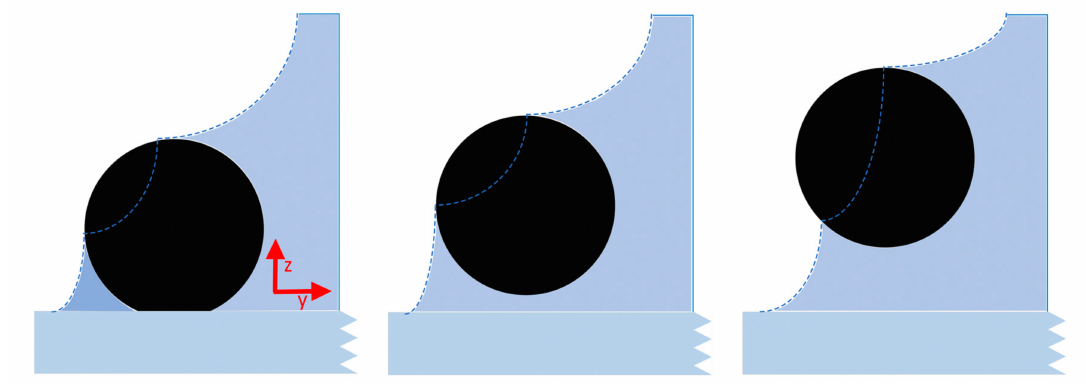
Figure 12. Particles detach from the surface when encountering a receding gas–liquid interface, lift up, and move with the fluid.